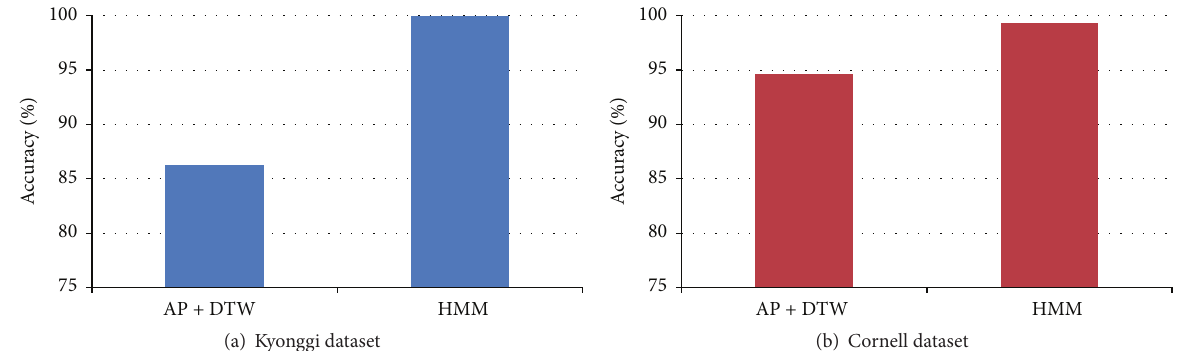
Figure 11: Recognition accuracy with different learning